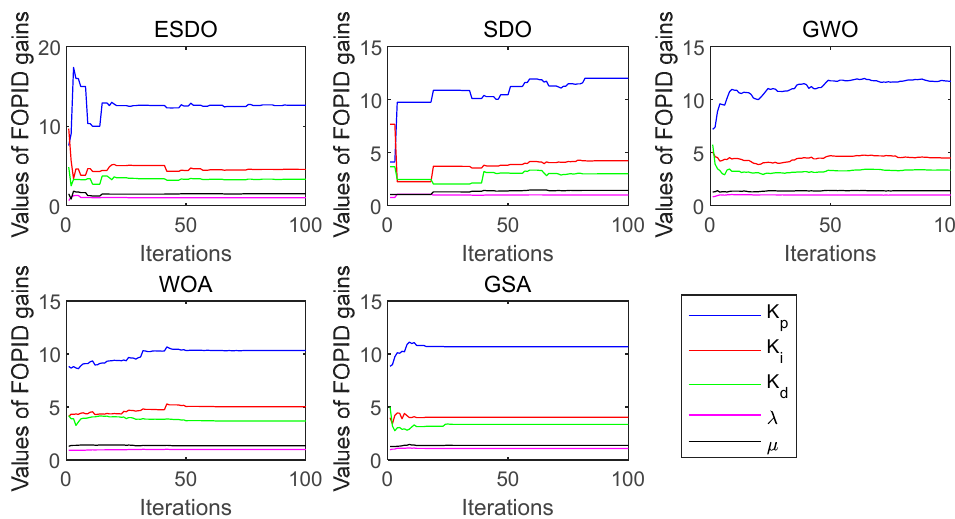
Figure 10. Convergence curves of FOPID parameters with 4% load.